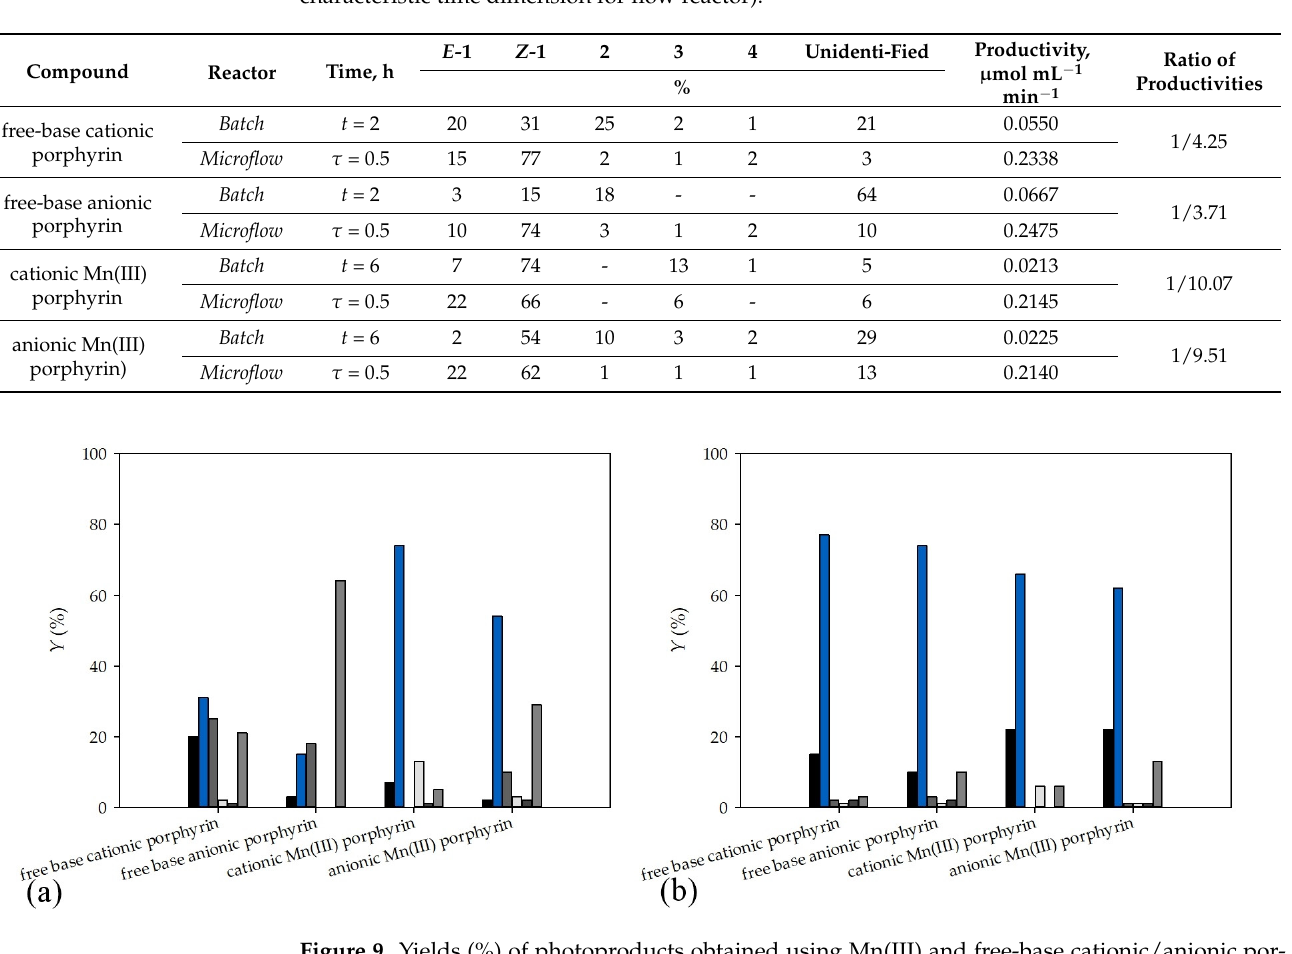
Figure 9. Yields (%) of photoproducts obtained using Mn(III) and free-base cationic/anionic porphy- rins and the remained E - 1 for reactions performed in ( a ) a batch reactor (2 and 6 h) and ( b ) microflow reactor ( τ = 30 min) ( ∎ E -1, ∎ cis -1, ∎ 2, ∎ 3, ∎ 4, ∎ undefined).